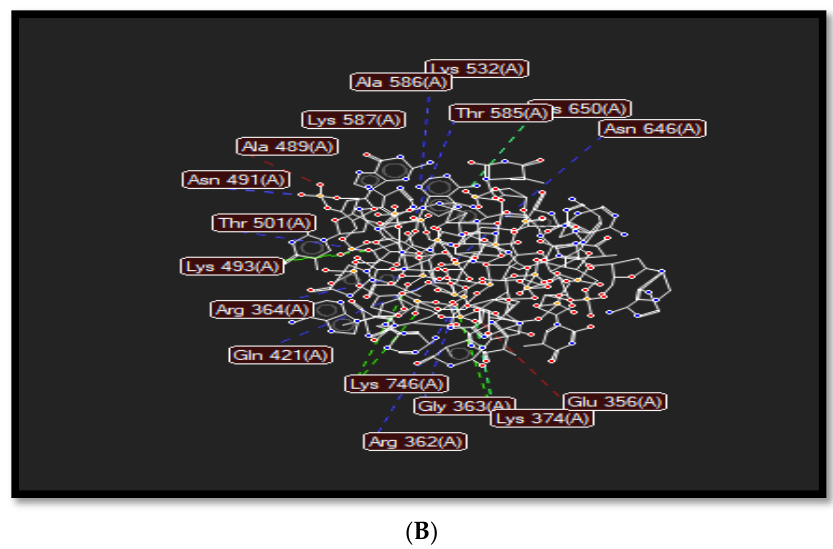
Figure 3. ( A ): Index number of acridine displayed in molecular interactions. ( B ) Representation of the molecular interactions of the 1t8i crystal structure, where blue dashed lines refer to hydrogen bond interactions, green dashed lines display electrostatic interactions and red lines show steric interactions.